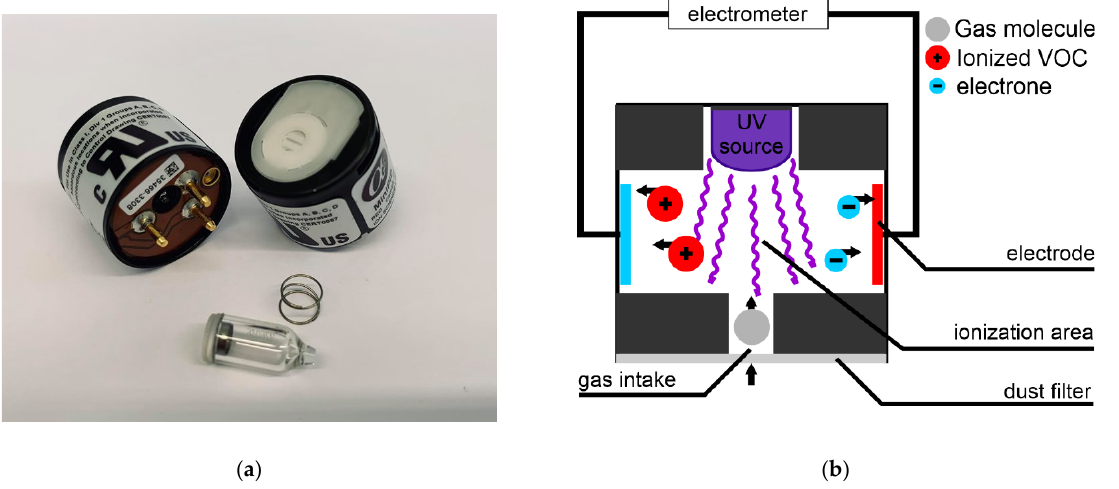
Figure 1. ( a ) Mini-PID sensor appearance. The outer diameter of the sensor is 20 mm. The lamp (in the front) in the assembled state is hidden under the white ionization chamber; ( b ) simplified principle of the photoionization measurement in the chamber. Spatial layout of the electrodes and UV source may vary in practice. Table 1. Mini-PID sensor specifications (manufacturer’s technical information [13,15]).